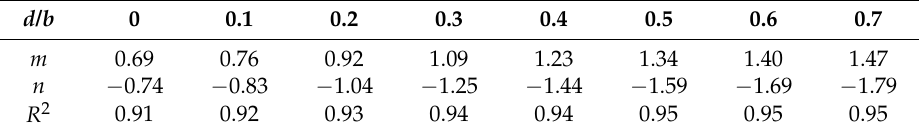
Table 3. The relationship d / b with m and n.